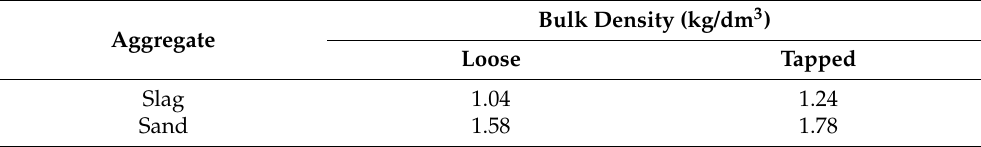
Table 2. The bulk density of sand and slag.